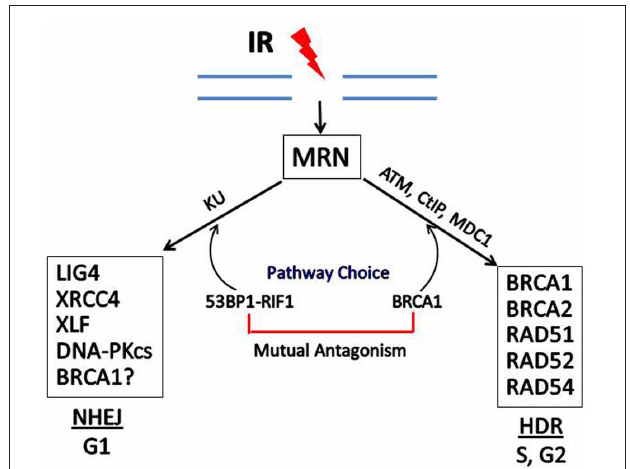
FIGURE 4 | Double-strand break repair by homology-directed repair (HDR) or non-homologous end joining (NHEJ). In response to IR, the MRN complex recognizes and binds to the broken ends of DNA at DSBs. DSB repair can occur by NHEJ or HDR, depending upon the phase of the cell cycle and the relative levels of BRCA1 vs. 53BP1 which has been phosphorylated by ATM and is complexed with RIF1. Some of the proteins involved in NHEJ and HDR are shown in the boxes. In addition to HDR, BRCA1 may participate in one subtype of NHEJ, but the role of BRCA1 in NHEJ is still not